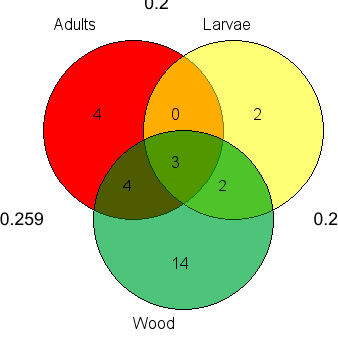
Figure 2. Venn diagram illustrating the unique and shared fungal taxa among insect adults (red), larvae (yellow), and wood tissues (green). Outside numbers are the Jaccard similarity coefficient.